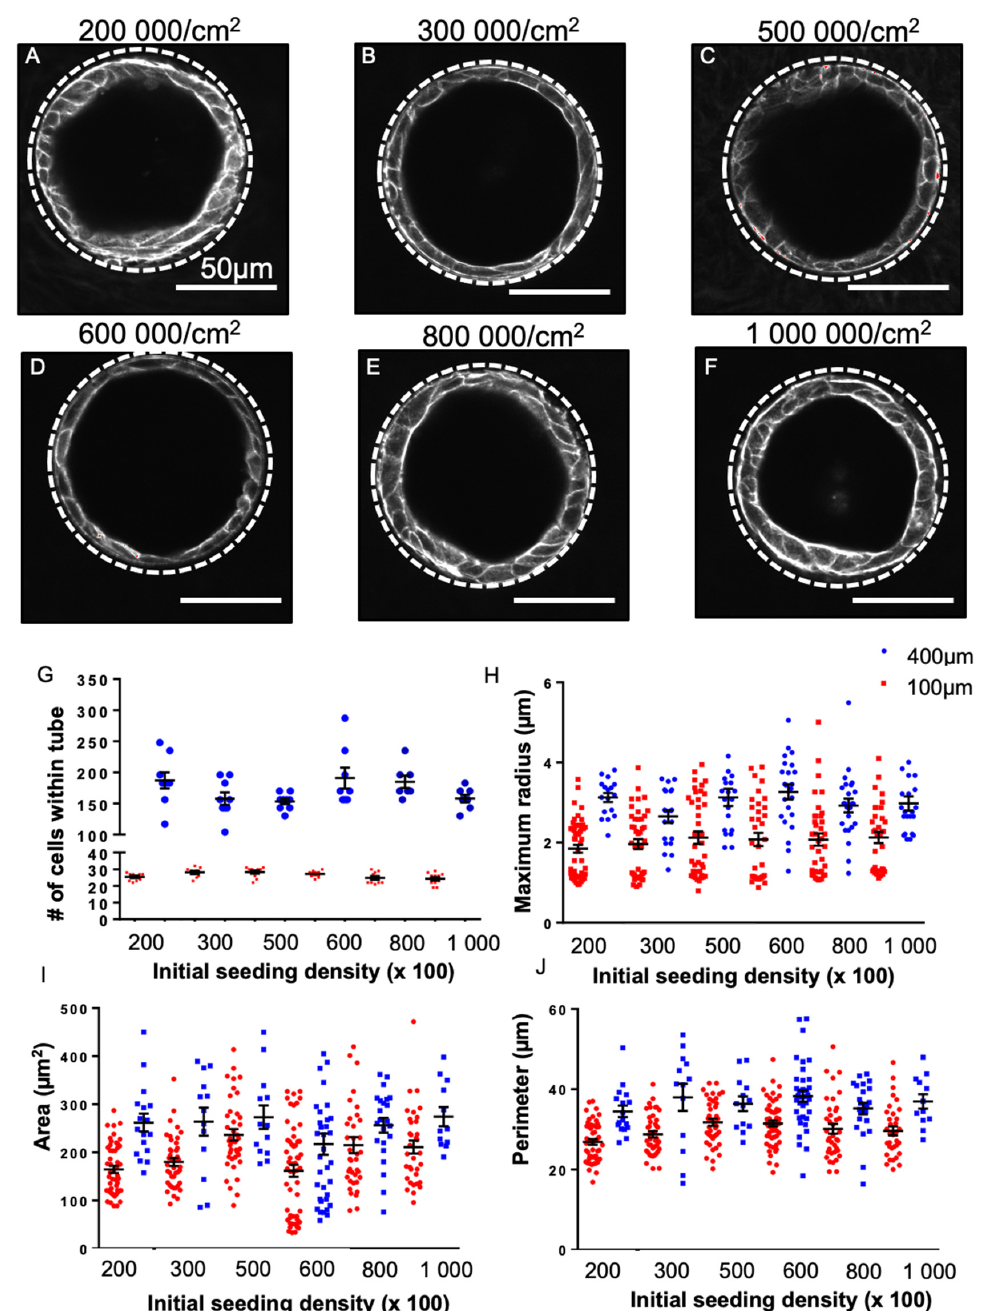
Figure 5. Cell seeding over a range of densities and corresponding cell morphometry. Fluorescent micrographs of day 17 lung progenitor cells seeded for 8 days in 100 µ m tubes and stained for F-actin (white) at 200,000 cells/cm 2 ( A ), 300,000 cells/cm 2 ( B ), 500,000 cells/cm 2 ( C ), 600,000 cells/cm 2 ( D ), 800,000 cells/cm 2 ( E ), 1,000,000 cells/cm 2 , ( F ) shows that tube formation occurs without aggregate formation at these cell seeding densities with appropriate washing. The number of cells per tube, 100 and 400 µm ( G ), was quantified; no significant differences were found between seeding conditions within the same sized tubes; n = 3. ( H – J ) morphometric analysis of 100 (red) and 400 µm (blue) tubes at various seeding densities. The maximum radius ( H ), area ( I ), and perimeter ( J ) of cells seeded in 400 µm tubes were consistently larger than cells seeded in 100 µm tubes. Bar, 50 µm; the dotted white line approximates the PDMS border.